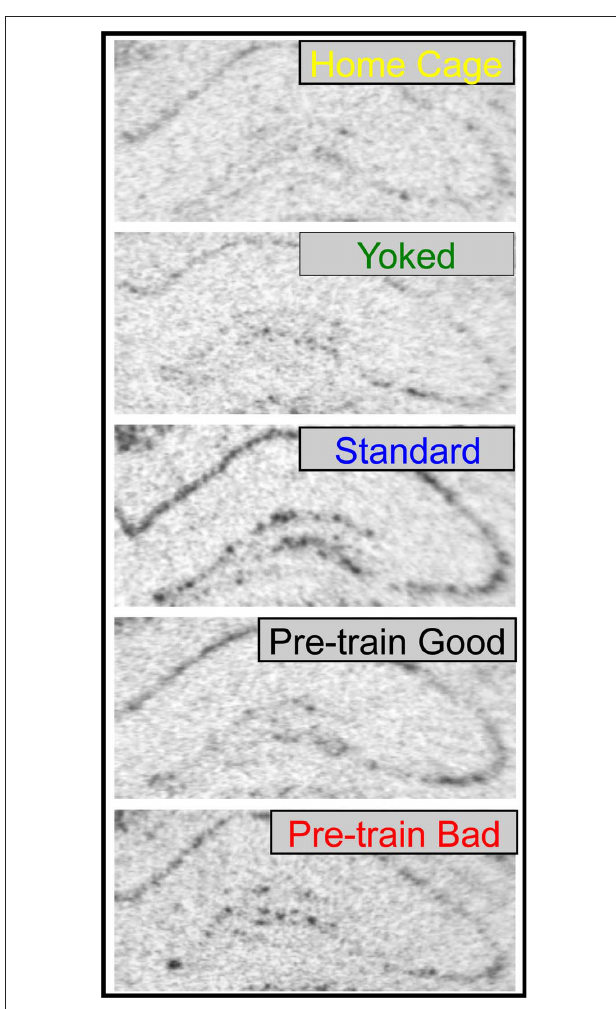
Figure 5 | representative dorsal hippocampus autoradiograms ( in situ hybridization) of c-fos mrNA following the 24-h memory test trial. Images from x-ray films were captured using a digital camera. The displayed images depict the dorsal hippocampus from one hemisphere of a coronal